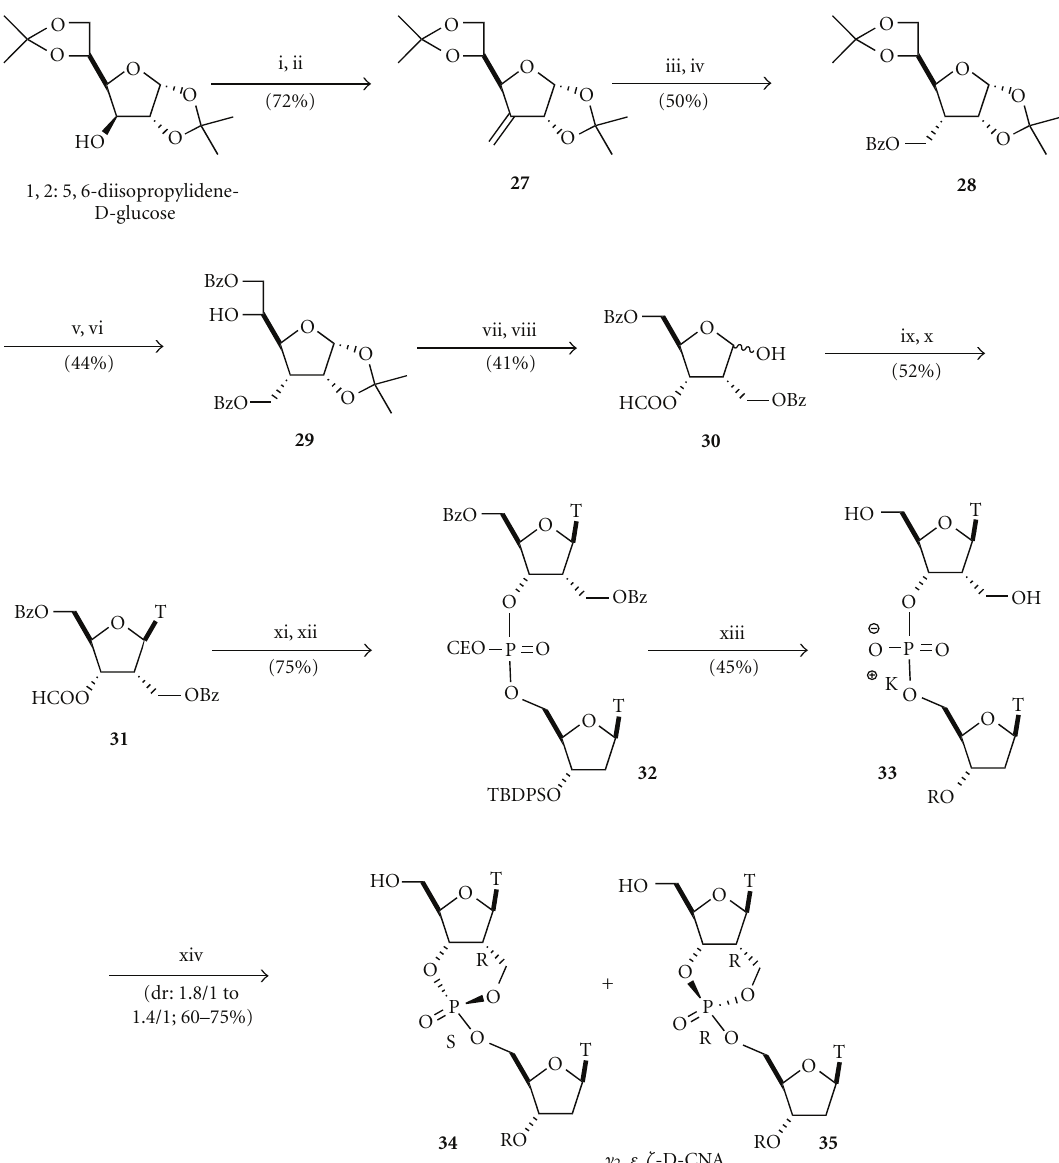
Scheme 5: Synthesis of ν 2 , ε , ζ -Dioxaphosphorinane-Constrained Nucleic Acid dinucleotides ( ν 2 , ε , ζ -D-CNA). Reagents and conditions :